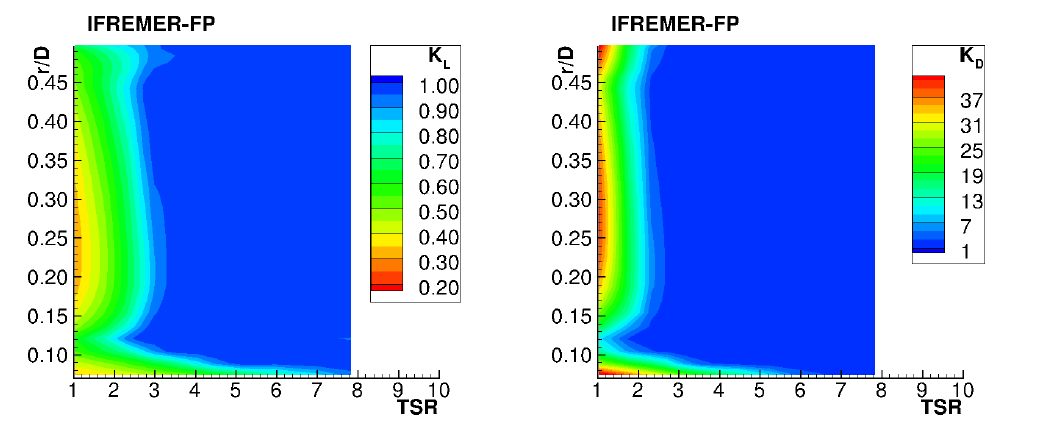
Figure 11. IFREMER-FP turbine. Correction factors for radial contributions to lift ( left ) and drag ( right ) as a function of radius r and of TSR